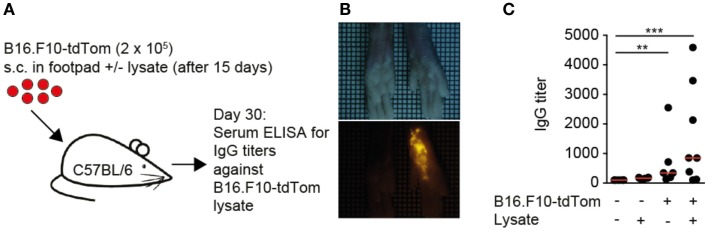
Local melanoma tumors generate systemic circulating IgG levels. (A). Outline of local tumor injection experiment. B16.F10-tdTom+ cells were s.c. injected into C57BL/6 mice on day 0 and allowed to proliferate for 30 days. In some mice, B16.F10-tdTom lysate was additionally s.c. injected to test whether IgG production can be boosted. (B) Brightfield (top) and red fluorescent (bottom) stereomicroscopic images of tumor-injected and contralateral footpads on day 30. (C) IgG titers in control and tumor-bearing mice on day 30, with and without additional B16.F10-tdTom+ cell lysate injection for 15 days. Each dot represents the serum of one mouse. Data in (C) are pooled from two independent experiments and were analyzed by a Kruskal–Wallis test with Dunn’s multiple comparison test. **p < 0.01, ***p < 0.001.